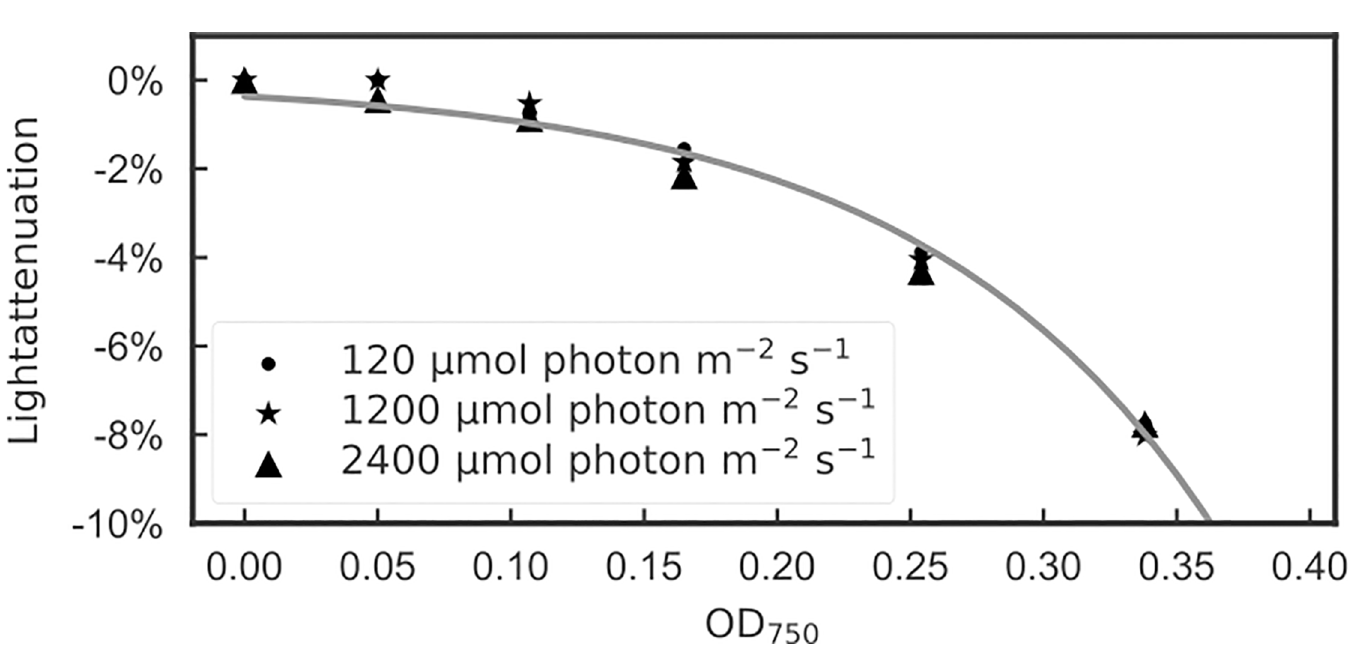
Fig 4. Empirical determination of PAR light attenuation within the ALG instruments measurement cuvette as a function of OD 750 . For OD 750 less than 0.35 the effect of culture density has less than 10% reduction of